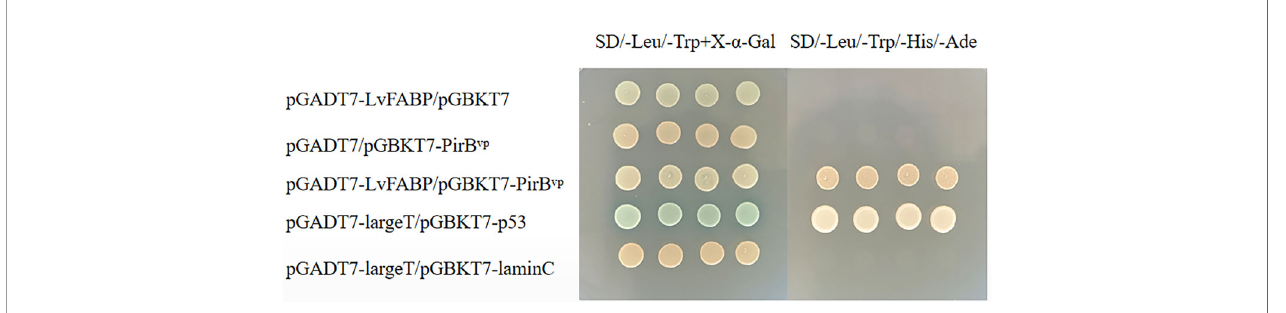
FIGURE 2 | Yeast two-hybrid pairwise analysis of the interaction between LvFABP and PirB vp. There were fi ve groups of experiments: pGADT7-LvFABP/pGBKT7, pGADT7/pGBKT7-PirB vp , pGADT7-LvFABP/pGBKT7-PirB vp , pGADT7-largeT/pGBKT7-p53, and pGADT7-largeT/pGBKT7-laminC. pGADT7-largeT/pGBKT7-p53 was used as a positive control, and pGADT7-largeT/pGBKT7-laminC was used as a negative control.